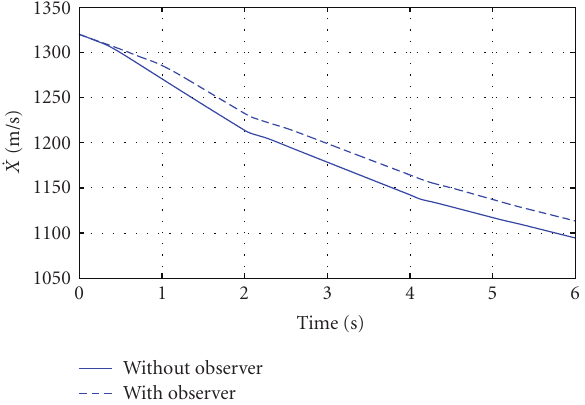
Figure 13: Horizontal speed, ˙ X , with/without observer.